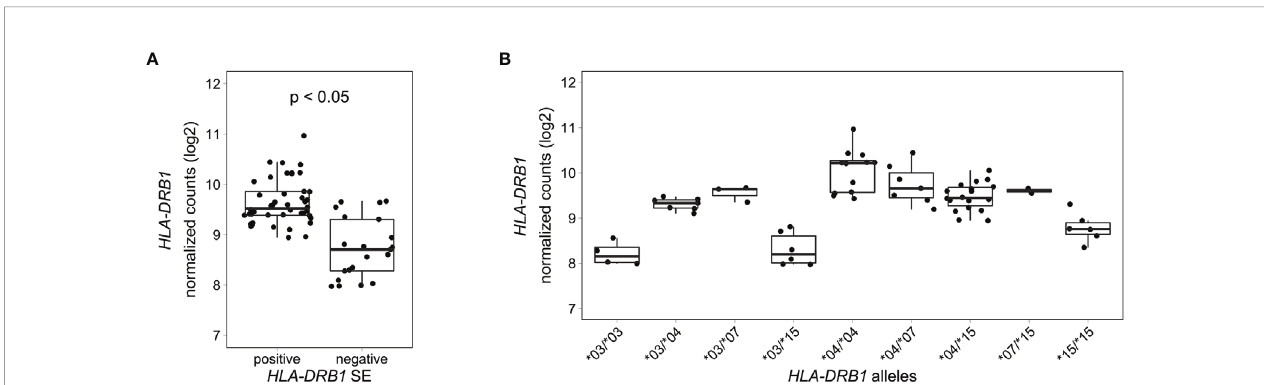
FIGURE 6 | HLA-DRB1 expression levels in whole blood samples of RA patients. (A) HLA-DRB1 gene expression in whole blood samples of HLA-DRB1 SE-positive [*04 ( n = 44)] and SE-negative [*03, *07, and *15 ( n = 21)] RA patients. (B) HLA-DRB1 gene expression in whole blood samples of RA patients carrying different combinations of HLA-DRB1 alleles [*03/*03 ( n = 4), *03/*04 ( n = 7), *03/*07 ( n = 3), *03/*15 ( n = 6), *04/*04 ( n = 12), *04/*07 ( n = 7), *04/*15 ( n = 18), *07/*15 ( n = 2), and *15/*15 ( n = 6)]. P, adjusted P -value